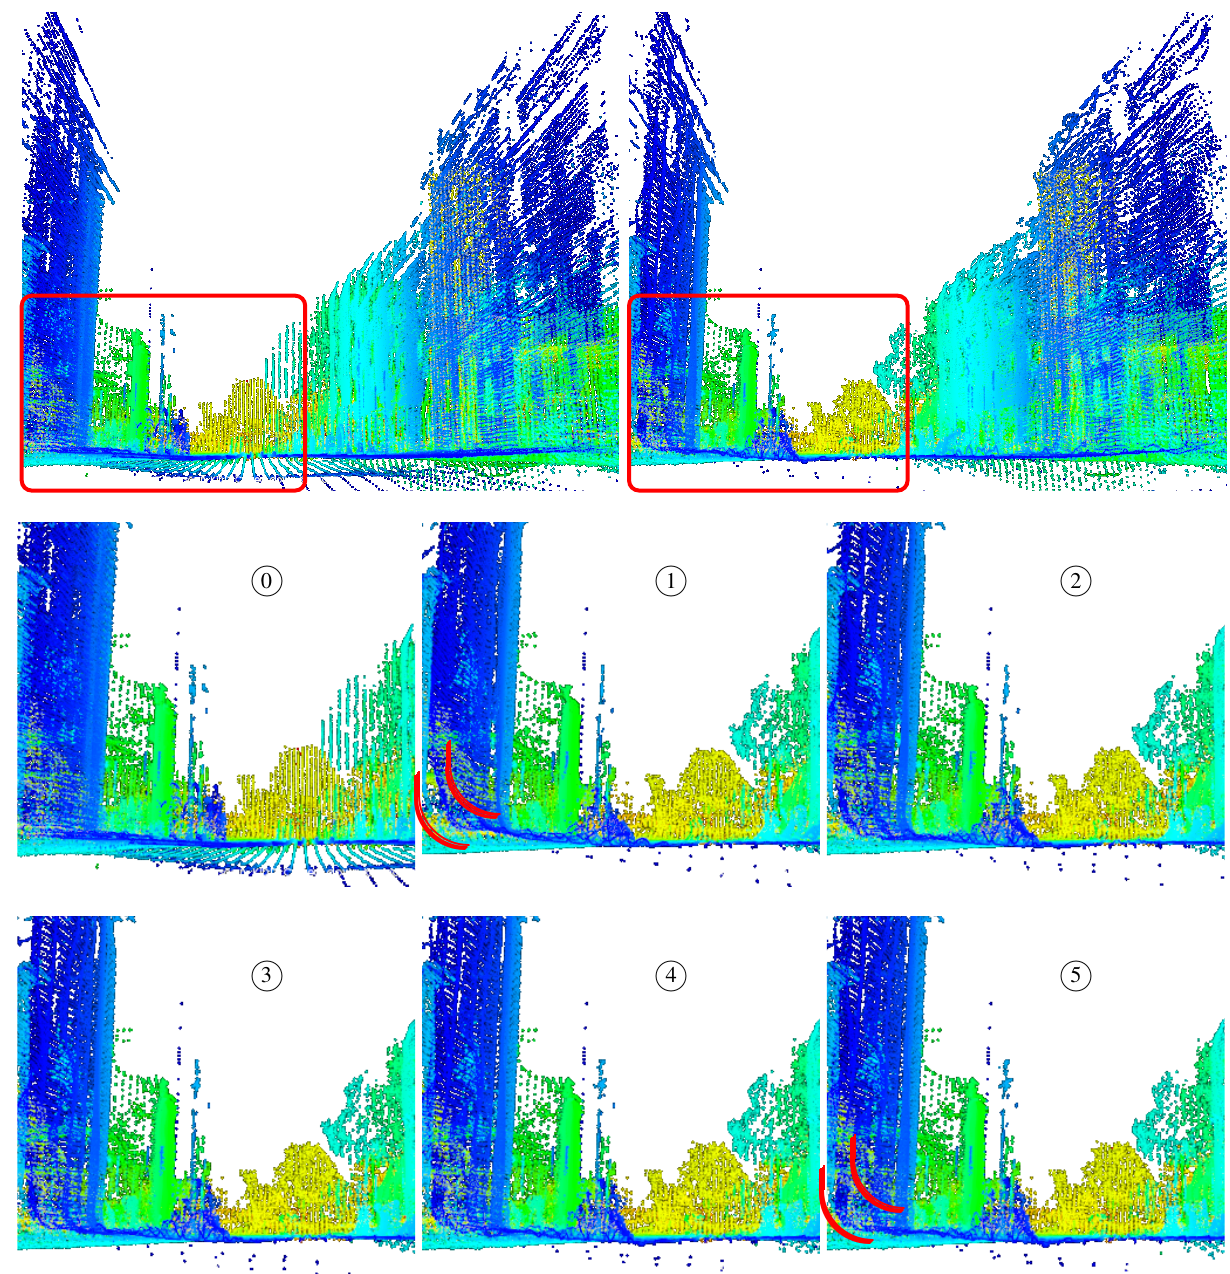
Figure 10. Top row: Result of fusion, left: with standard ICP only, right: with ICP and an additional step with surface smoothing using a polynomial of order 5 . Thereto, the points from landscape model are projected on polynomial models through LiDAR points. A box is marked in both views. This extract is documented in the two rows below. There, the results without polynomial fittings ( 0 ) and with polynomial fittings of degree 1 to 5 are visualized in the according subfigures. Additionally, we marked the area of a building footprint in two views. The increased accuracy along the edge between facade and road can get inspected. Furthermore, notice the disappearance of the doubled road surface. This happens already at 1st order polynomial surface